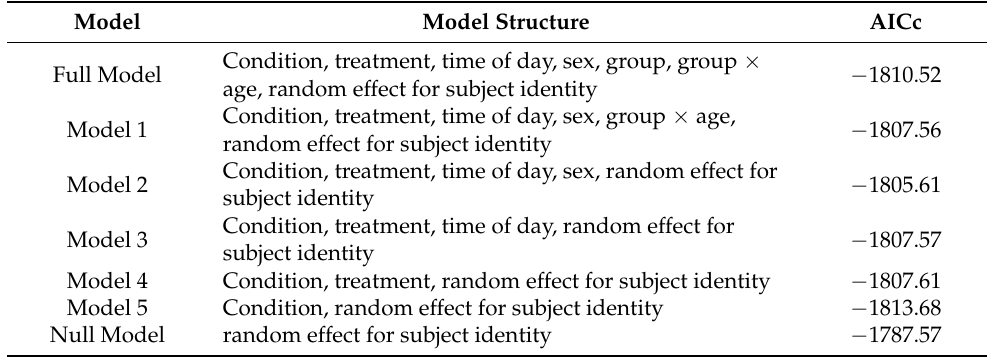
Table 6. Model structures and AIC values obtained during model selection for abnormal behaviours.